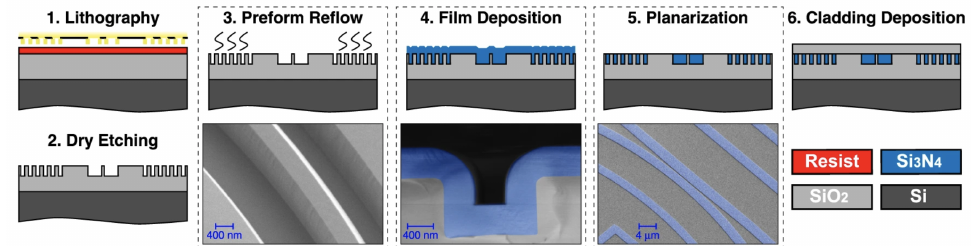
Figure 2. Damascene reflow process steps including lithography, preform dry etching, preform reflow, LPCVD Si 3 N 4 deposition, planarisation and cladding deposition. Reproduced from [21] under a CC BY 4.0